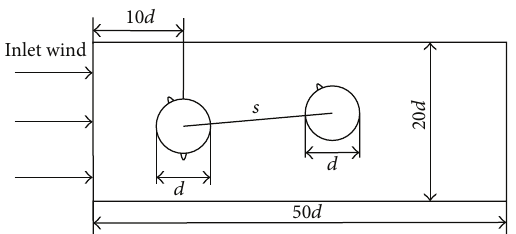
Figure 1: Oscillation of the leeward conductor under the rain-wind conditions.